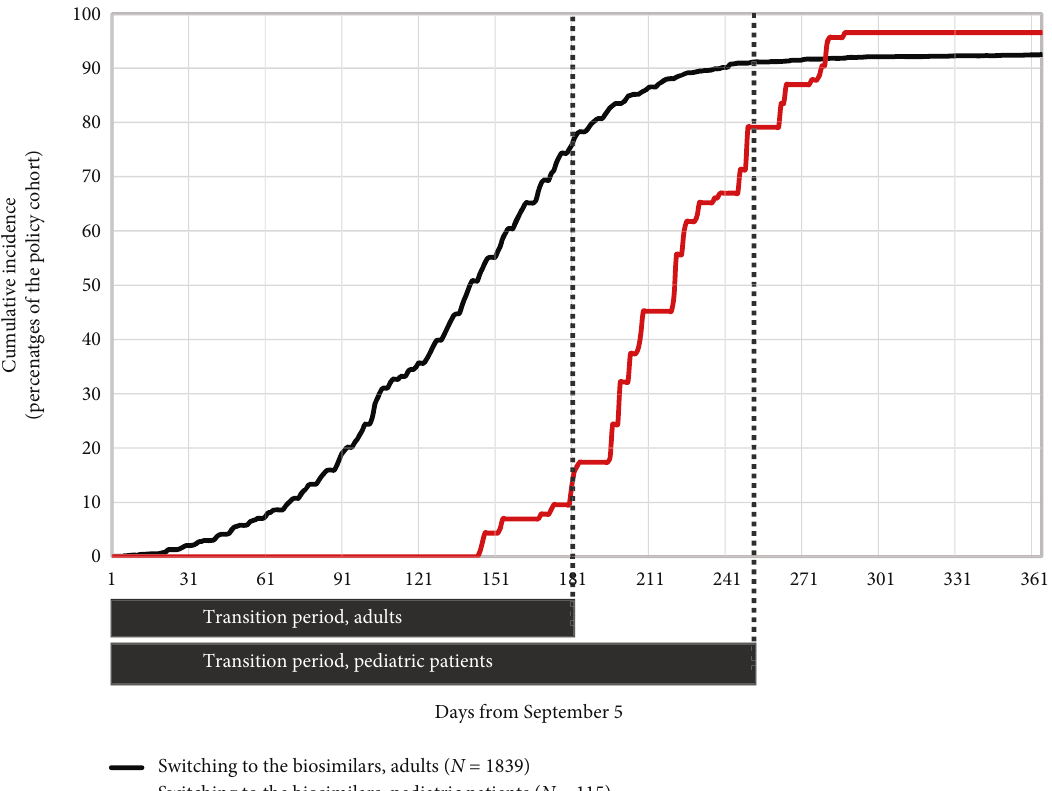
Figure 2: Transition to biosimilar in fl iximab: percentage of adult and pediatric patients with in fl ammatory bowel diseases who were previously treated with originator in fl iximab (brand name Remicade) and switched to biosimilar in fl iximab following the policy launch. The transition period of the Biosimilars Initiative started on 5 September 2019 and ended on 4 March 2020 for adults and on 15 May 2020 for pediatric patients. Patients with in fl ammatory bowel diseases were identi fi ed based on the algorithm presented in Supplementary Table 1 (policy